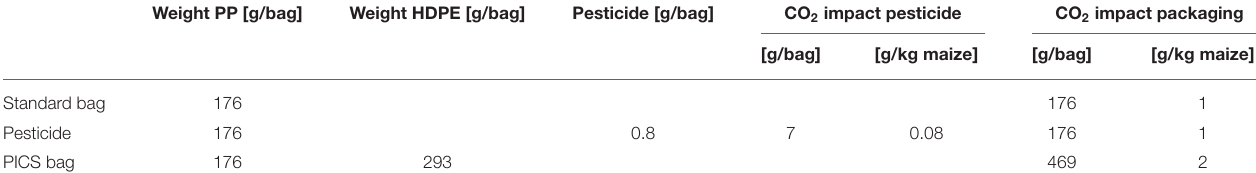
TABLE 3 | GHG emissions for packaging (90kg) for the different scenarios (kg CO 2 -eq. emissions per kg food-grade maize).